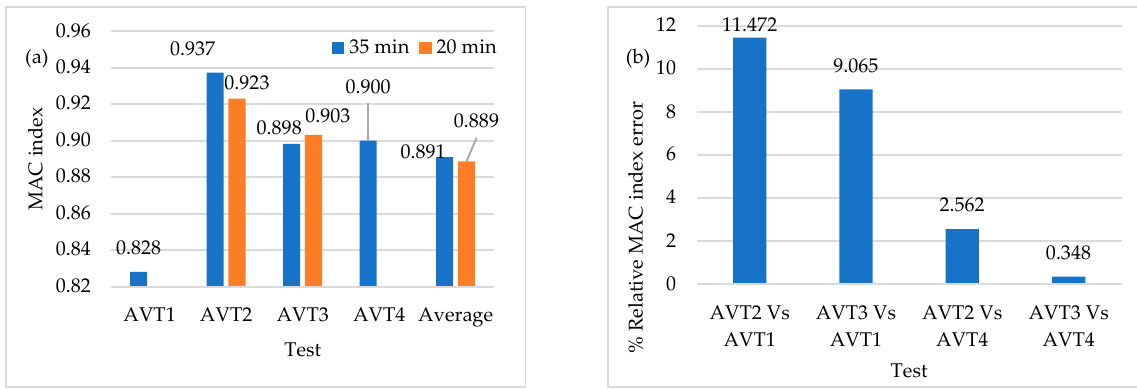
Figure 18. ( a ) Average values of MAC index of AVTs ( b ) Percentage of relative MAC index error of AVTs with full time- series length.